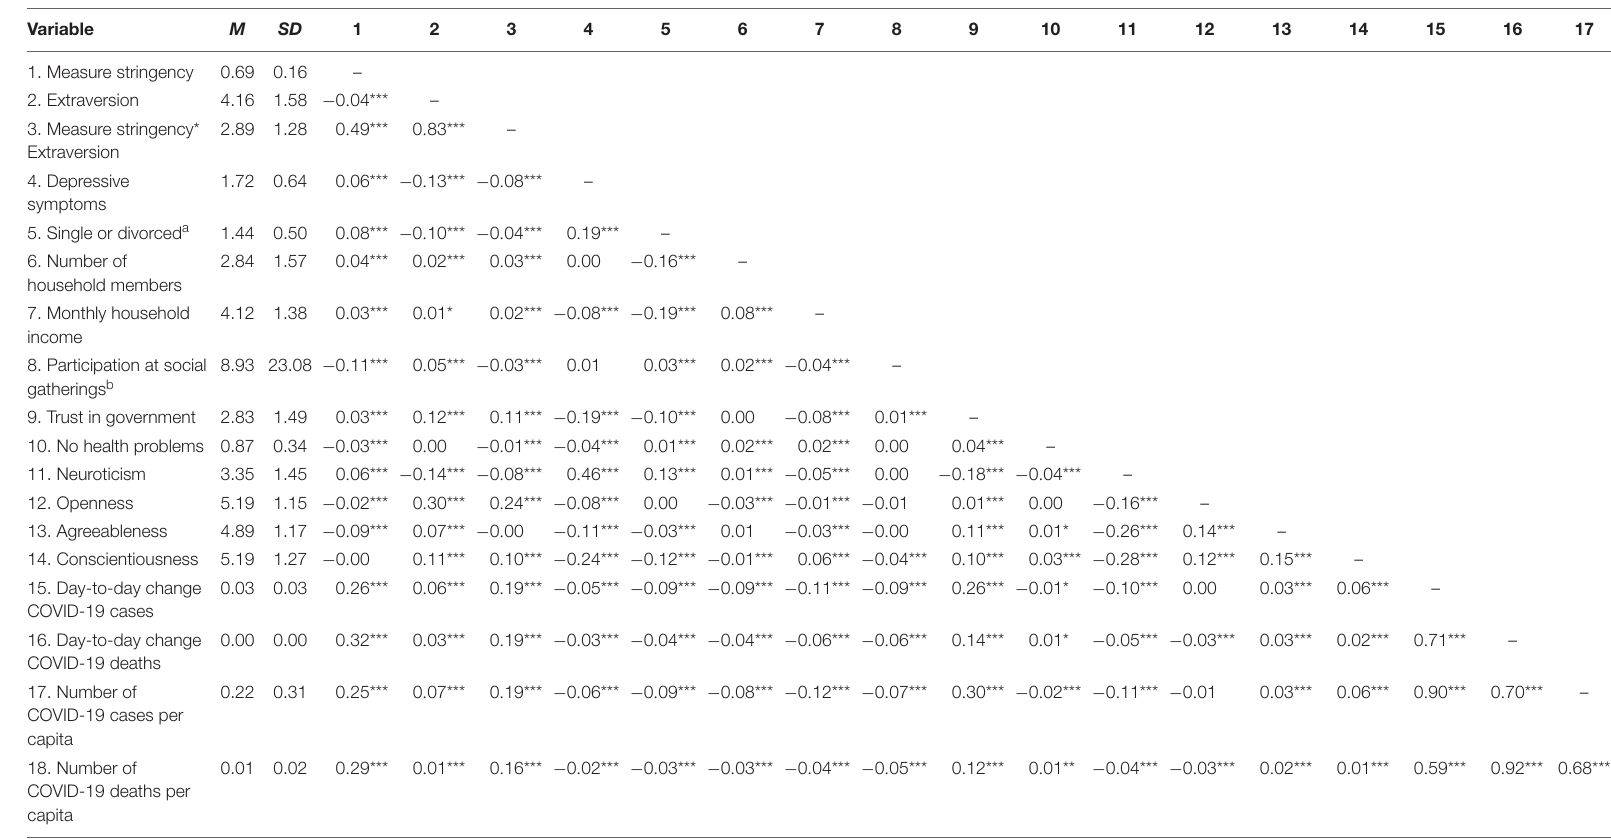
TABLE 2 | Means, standard deviations, and Pearson correlation matrix ( N = 93,125).